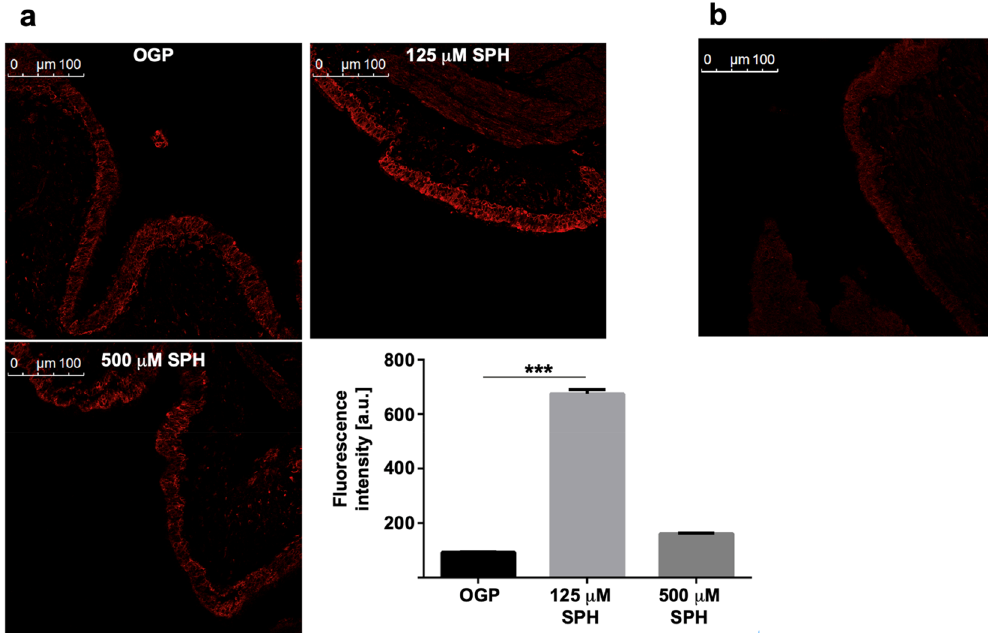
Figure 1. ( a , b ) Fluorescence intensity after staining with Cy3-coupled anti-sphingosine ( a ) and autofluorescence intensity without staining as control ( b ). Histological studies demonstrate an accumulation of sphingosine in bronchial epithelial cells after inhalation. EVLP minipig lungs were inhaled with sphingosine at concentrations of 125 µM sphingosine (SPH), 500 µM sphingosine (SPH) and with 0.125% octylglucopyranoside (OGP) as control. The lungs were subjected to bronchoscopy 30 and 150 min after the inhalation, biopsies were fixed in paraformaldehyde, embedded in paraffin and sectioned. Sections were stained with Cy3-coupled anti-sphingosine and without coupling (control). Shown are representative immune stainings. Given is the mean ± SD from 3 sections with 5 visual fields per animal (blinded tests), * p < 0.05, ** p < 0.01, *** p < 0.001,